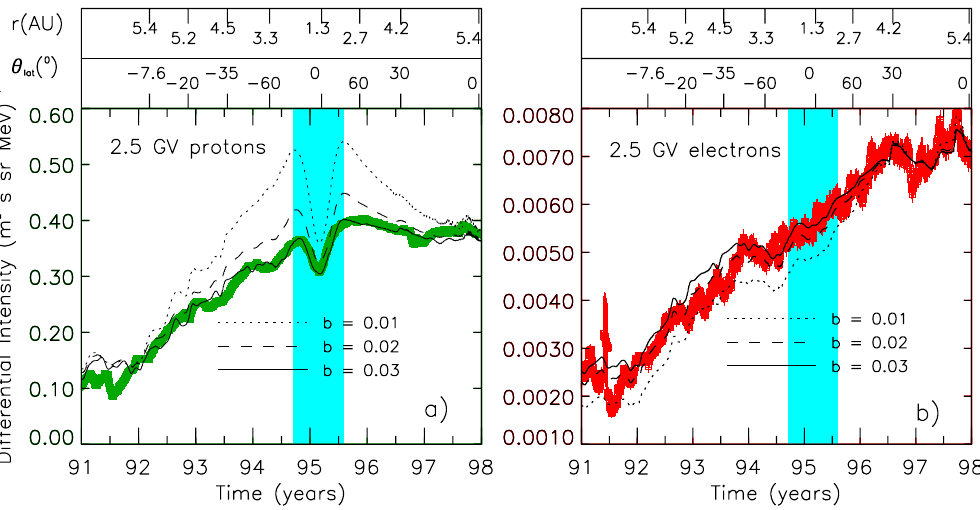
Fig. 3. (a) Computed 2.5GV proton intensity and (b) 2.5GV electron intensity along Ulysses’ trajectory in comparison with 2.5GV data from the Ulysses/KET instrument (Heber et al., 1996, 1999,